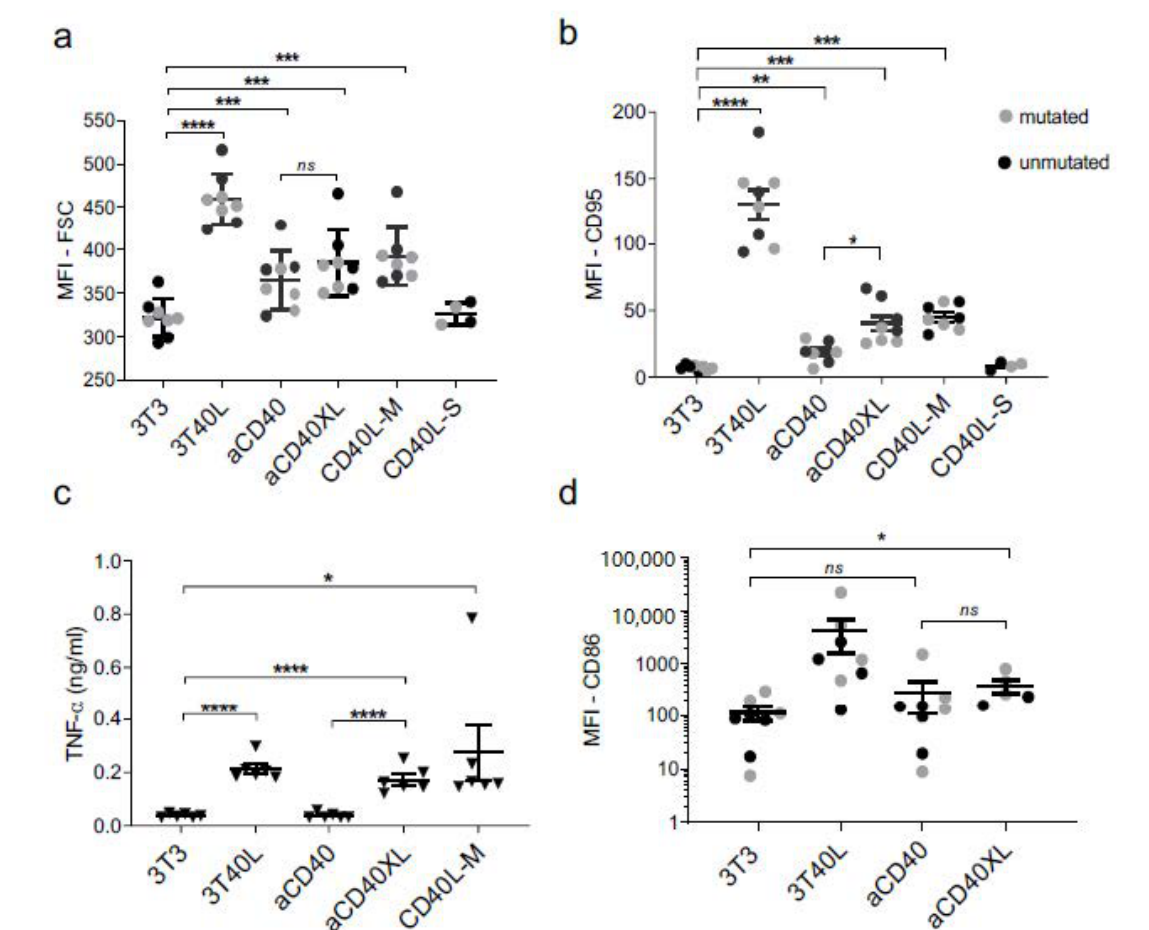
Figure 2. Activation of CLL cells with selicrelumab and comparison with distinct modes of CD40 stimulation. CLL cells were cultured for 48/72 h on fibroblasts (3T3), fibroblasts transfected with human CD40L (3T40L), selicrelumab with and without an IgG crosslinker (aCD40 ± XL), CD40 ligand multimeric construct (CD40L-M), and CD40 ligand single (CD40L-S) for 48 h ( n = 8). ( a ) Blast formation/cell size accessed by flow cytometry. ( b ) CD95 expression accessed by flow cytometry. ( c ) TNF- α levels measured in culture supernatants by enzyme-linked immunosorbent assay (ELISA). ( d ) CD86 expression accessed by flow cytometry. Grey or black dots (IGVH mutated and unmutated IgVH status respectively) and symbol represent the mean ± SEM: * p < 0.05, ** p < 0.01, *** p < 0.001, **** p < 0.0001 (unpaired t